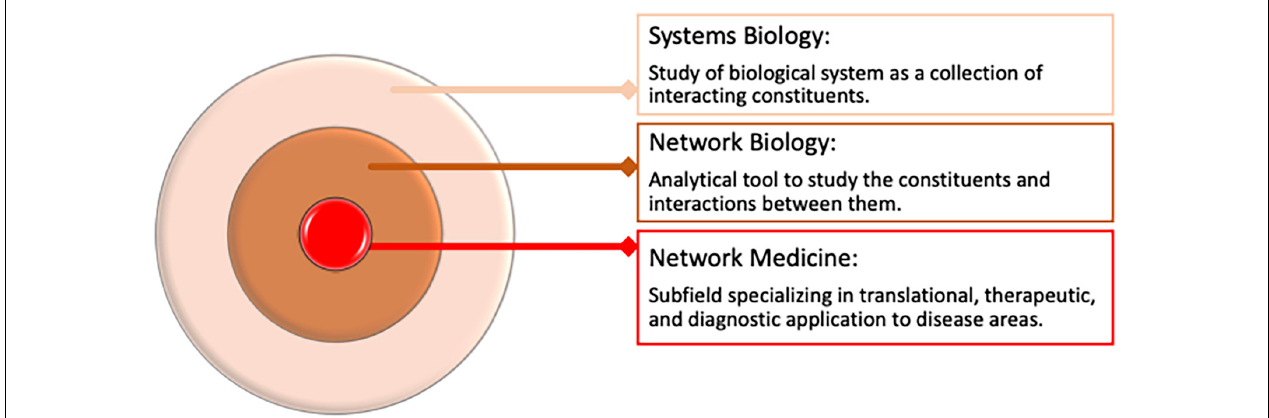
FIGURE 2 | Overview of Network Medicine in Biomedical Data Analysis and its relation to systems biology.